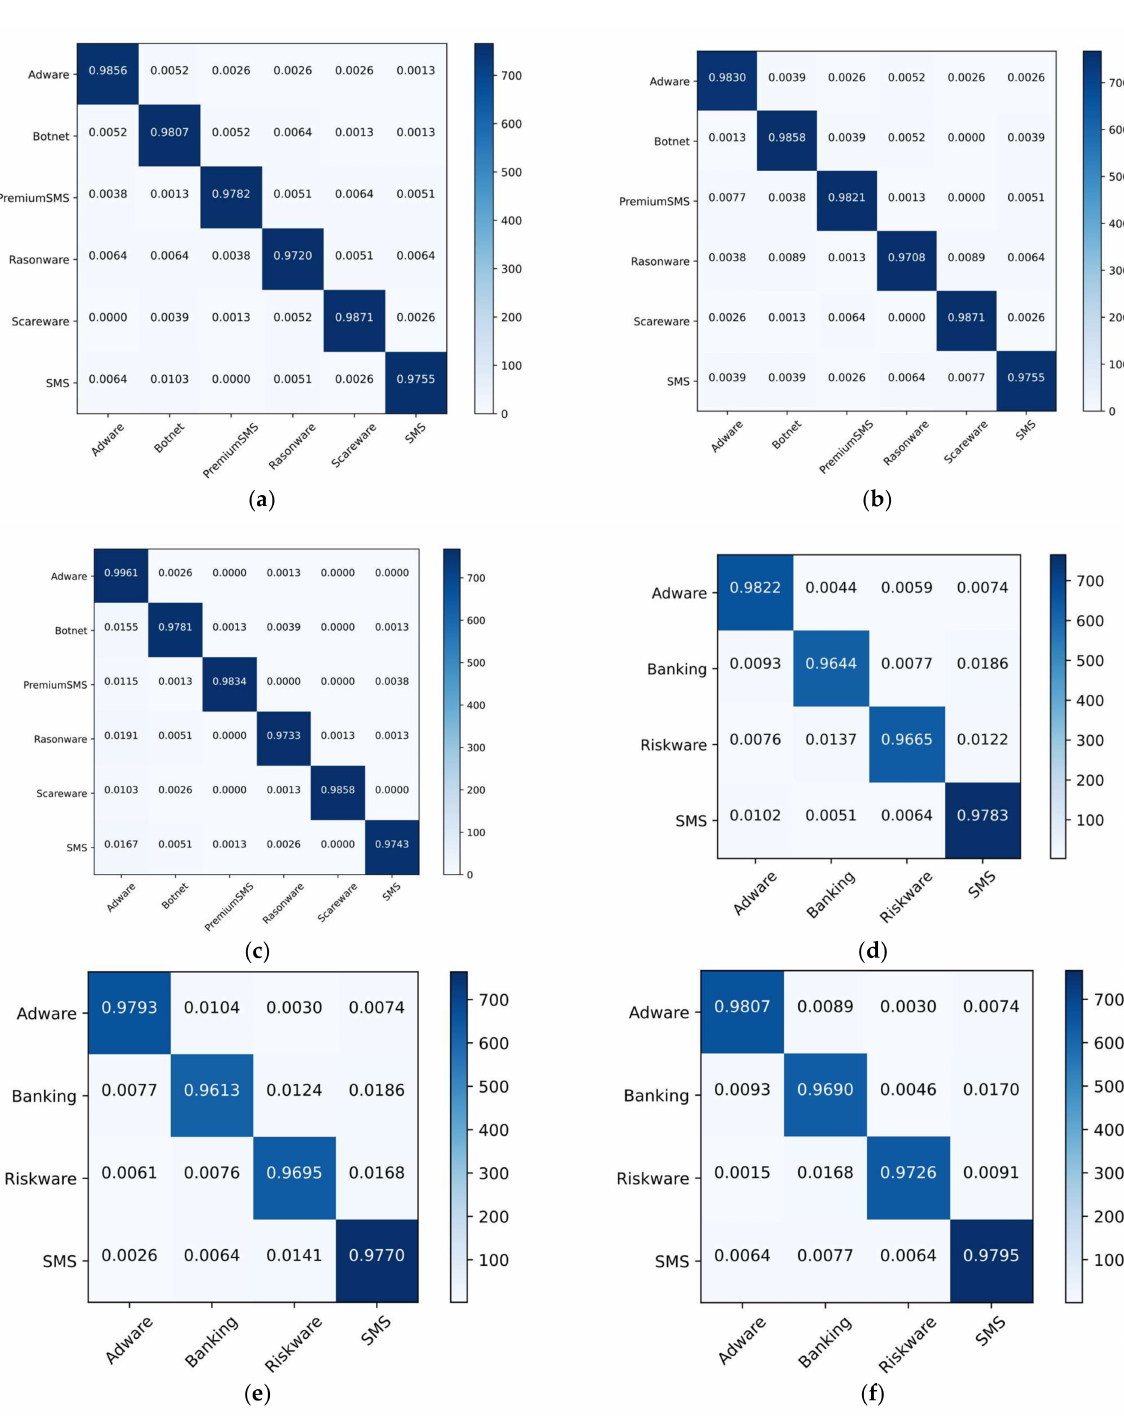
Figure 12. Confusion matrices for malware classification using both datasets for the top three algorithms: ( a ) DT; ( b ) RF; ( c ) RF; ( d ) DT; ( e ) RF; ( f )